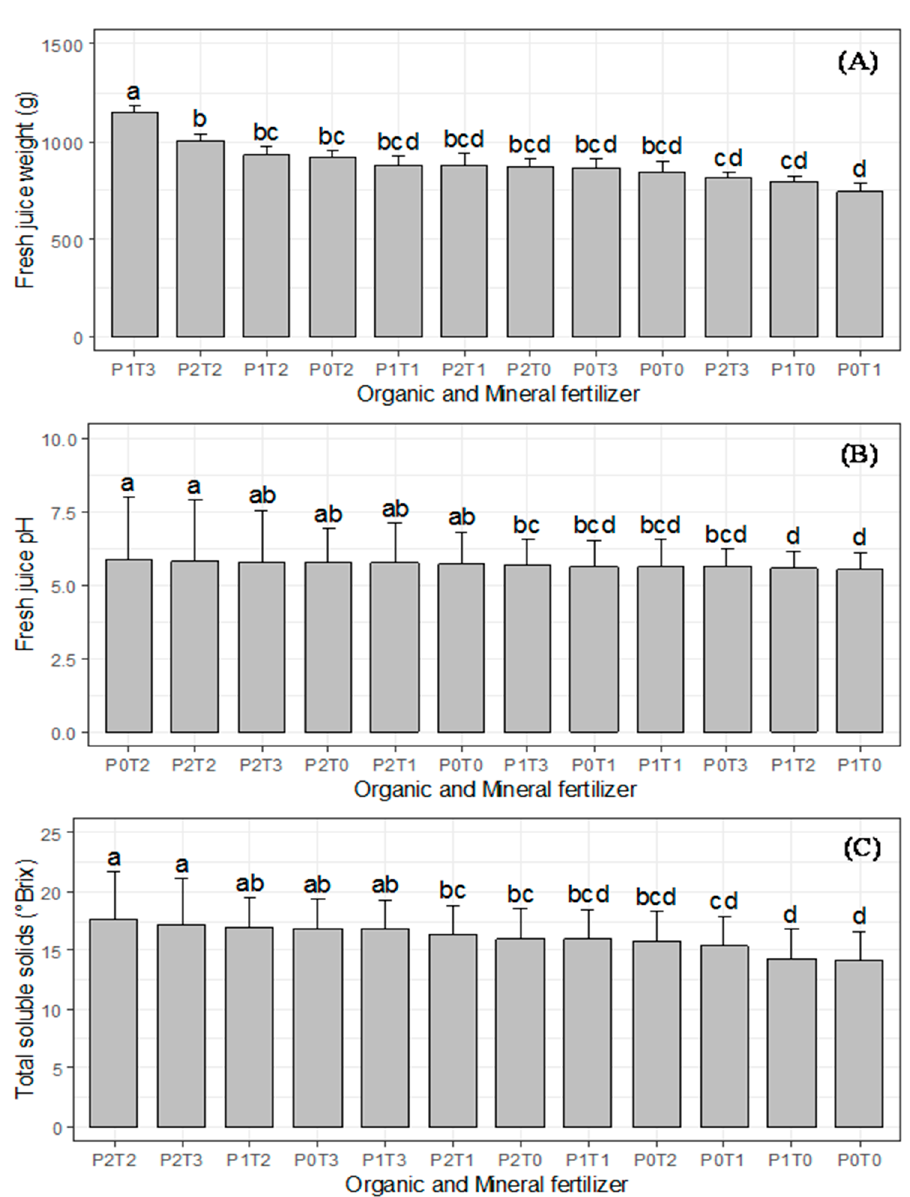
Figure 2. Effect of organo-mineral fertilizer on average fruit quality attributes: ( A ) fresh juice weight; ( B ) fresh juice pH; ( C ) Total soluble solids. P0T0: 0 t ha − 1 of poultry litter and N-P-K in Kg ha − 1 100-30-150, P0T1: 0 t ha − 1 of poultry litter and N-P-K in Kg ha − 1 200-60-300, P0T2: 0 t ha − 1 of poultry litter and N-P-K in Kg ha − 1 400-120-600, P0T3: 0 t ha − 1 of poultry litter and N-P-K in Kg ha − 1 600-180-900, P1T0: 5 t ha − 1 of poultry litter and N-P-K in Kg ha − 1 100-30-150, P1T1: 5 t ha − 1 of poultry litter and N-P-K in Kg ha − 1 200-60-300, P1T2: 5 t ha − 1 of poultry litter and N-P-K in Kg ha − 1 400-120-600, P1T3: 5 t ha − 1 of poultry litter and N-P-K in Kg ha − 1 600-180-900, P2T0: 10 t ha − 1 of poultry litter and N-P-K in Kg ha − 1 100-30-150, P2T1: 10 t ha − 1 of poultry litter and N-P-K in Kg ha − 1 200-60-300, P2T2: 10 t ha − 1 of poultry litter and N-P-K in Kg ha − 1 400-120-600, P2T3: 10 t ha − 1 of poultry litter and N-P-K in Kg ha − 1 600-180-900.